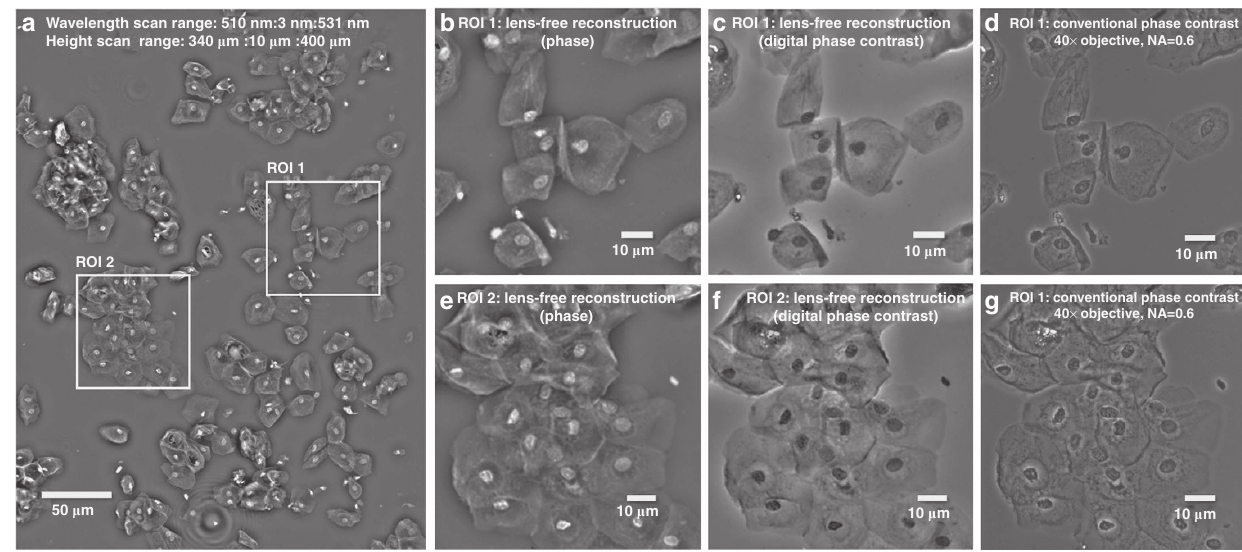
Figure 6 Lens-free imaging of a Papanicolaou (Pap) smear using wavelength-scanning pixel super resolution and multi-height phase retrieval. ( a ) Super-resolved lens-free phase image of the Pap smear. Wavelength-scanning range: 510 – 531 nm, scanning step: 3 nm. ( b , e ) Regions of interest (ROI) No. 1 and 2, respectively. ( c, f ) Digital phase contrast images generated from lens-free reconstructions (refer to the Materials and Methods section for details). ( d , g ) Conventional lens-based phase contrast images obtained using a 40× objective lens (NA =